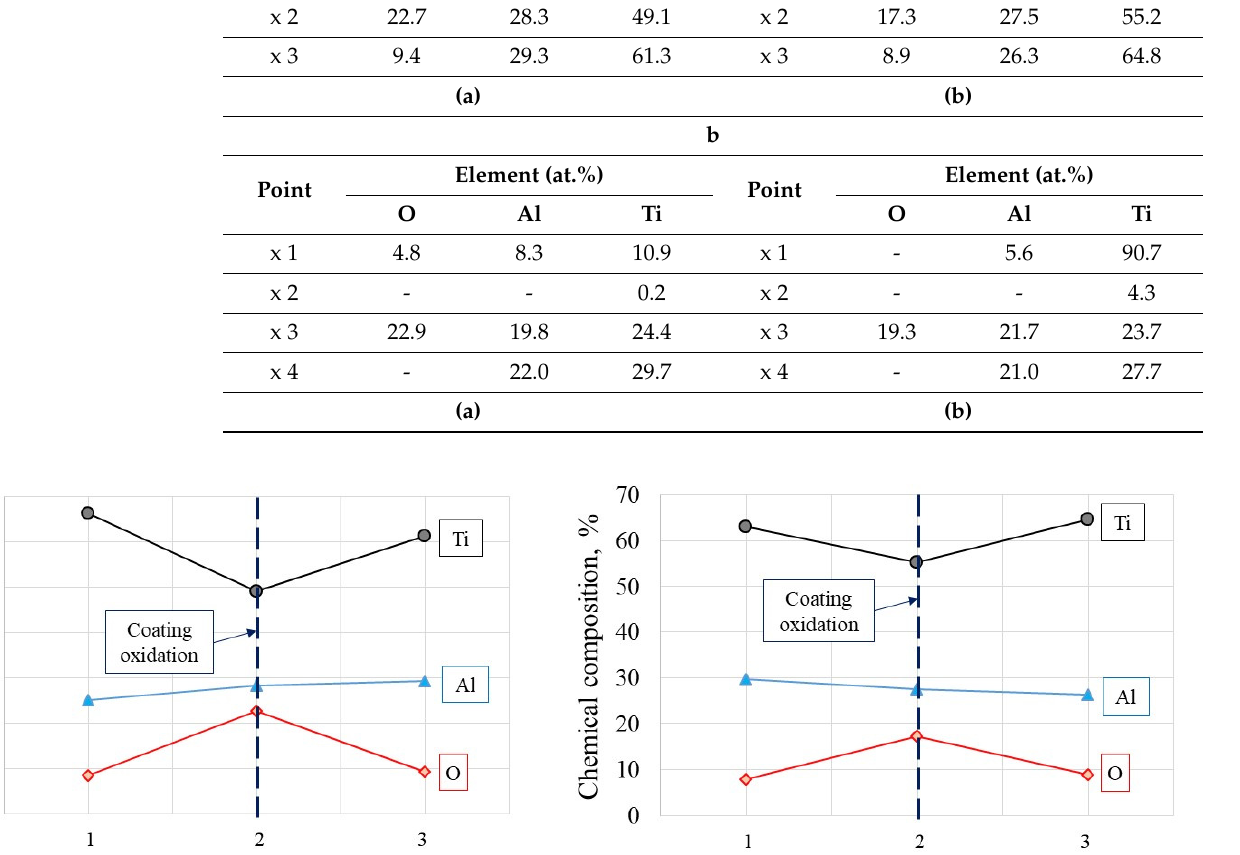
Figure 10. SEM images of flank faces obtained after machining of IN718 ( a ) and Ti6Al4V ( b ) workpieces with the cutting speed of 200 m/min; machining time of 2 min.